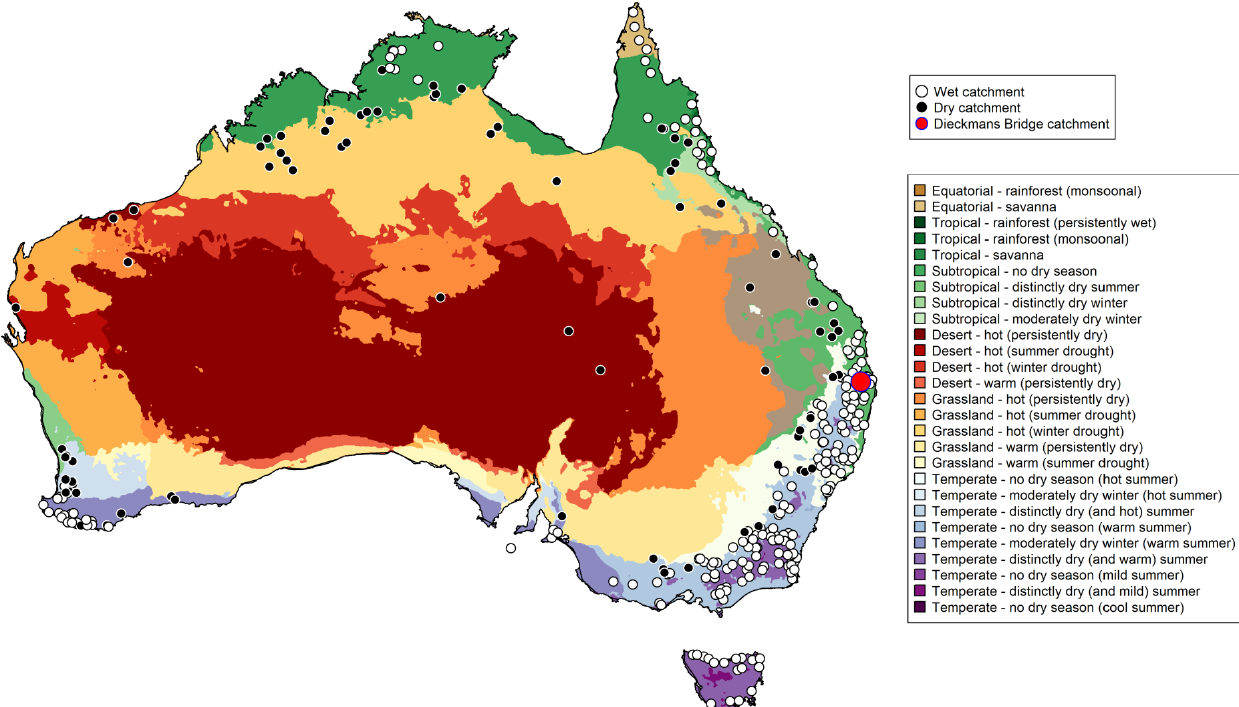
Figure 2. Locations of the 300 catchments used in this study. The catchments are classified as dry or wet based on the aridity index. The Köppen climate classifications for Australia are shown. The Dieckmans Bridge catchment (site id: 145010A), used as a representative catchment in Fig. 8, is indicated by the red